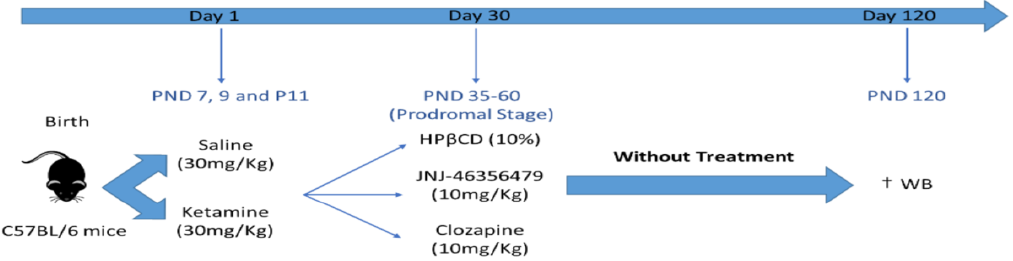
Figure 4. Design of the study. On PND 7, 9, and 11, the C57BL/6J mice were treated with either saline or 30 mg/kg ketamine. This is a study conducted in the prodromal stage of the disease, from 35 to 60 PND, when HP β CD, CLZ, or JNJ were administered daily. On PND 120, mice were sacrificed, and tissues were obtained for further analysis. HP β CD, hydroxypropyl-beta-cyclodextrin; JNJ, JNJ46356479; PND, postnatal days; WB, western blot. † day of sacrification.